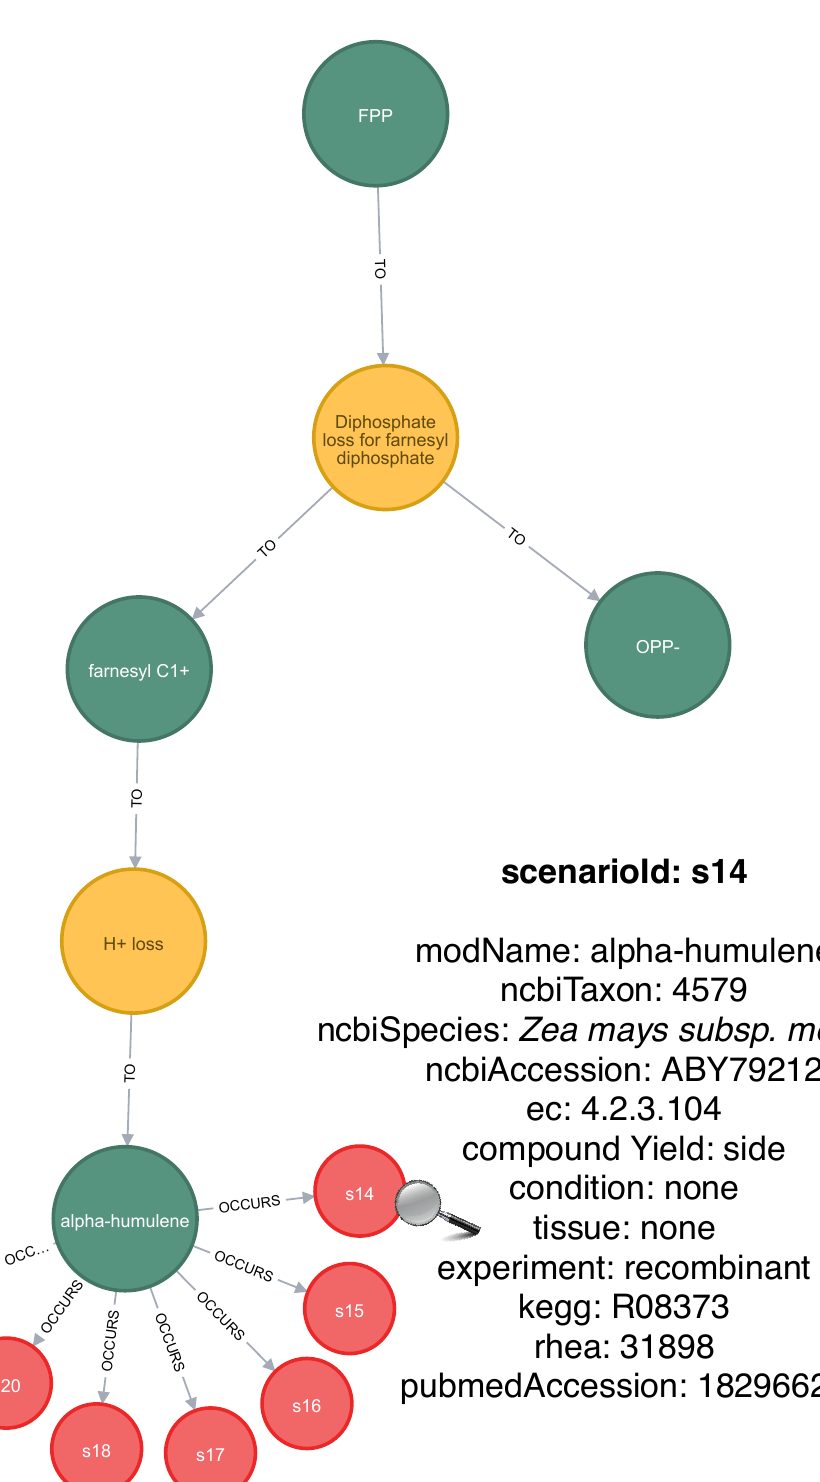
Figure 4. An example of a generated pathway stored in the Neo4J graph database. In this example, yellow nodes (label “Rules”) denote the rules “diphosphate loss” and “H + loss”. The green nodes (label “Compound”) denote compounds from FPP to α -humulene and other generated